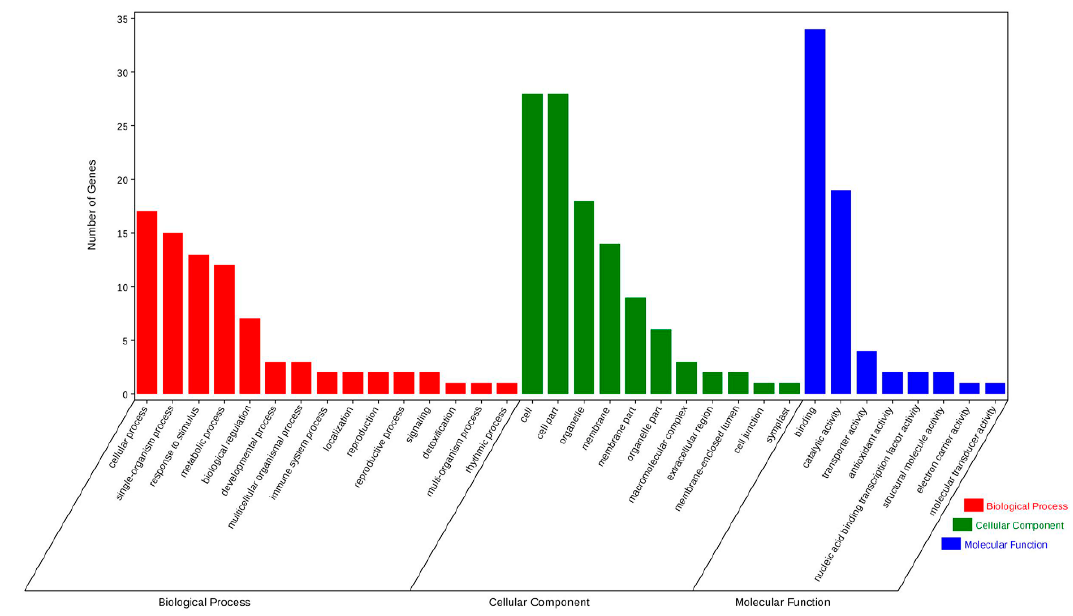
Figure 6. GO categories of the target genes for 25 DEmiRs.